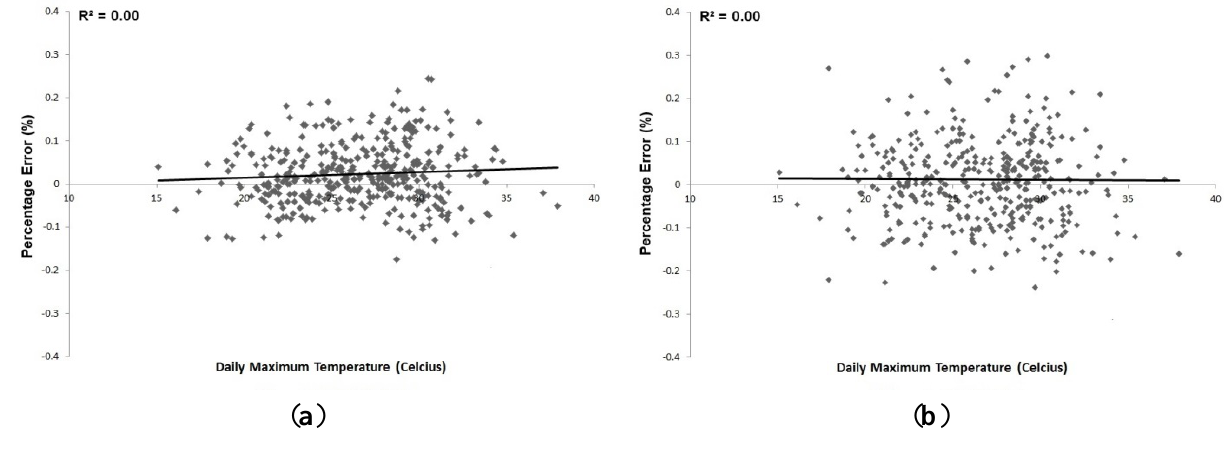
Figure 7. Phase 3’s ARIMAX ( a ) NDTEU and ( b ) NDPD error vs. daily maximum